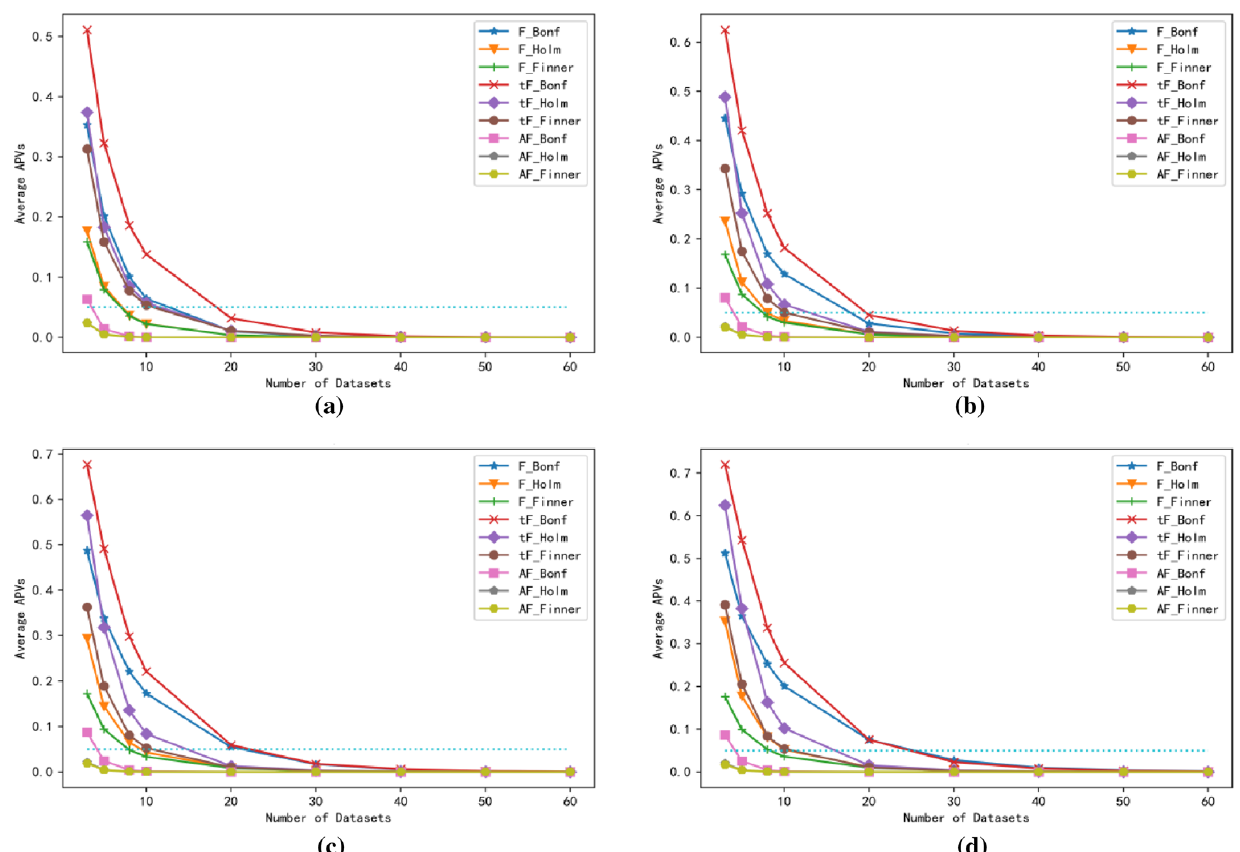
Fig. 9 Average APVs of different nonparametric statistical tests under the experiment setting iv: a the number of algorithms K = 4; b K = 6; c K = 8; d K =